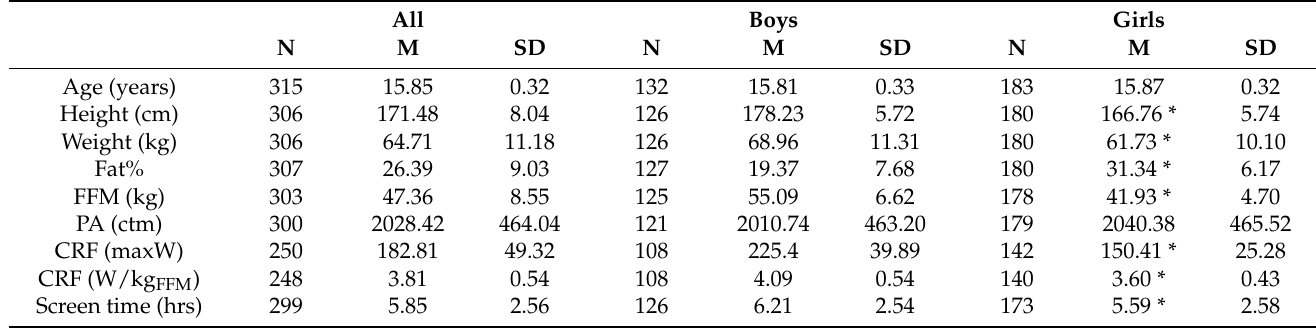
Table 1. Participants’